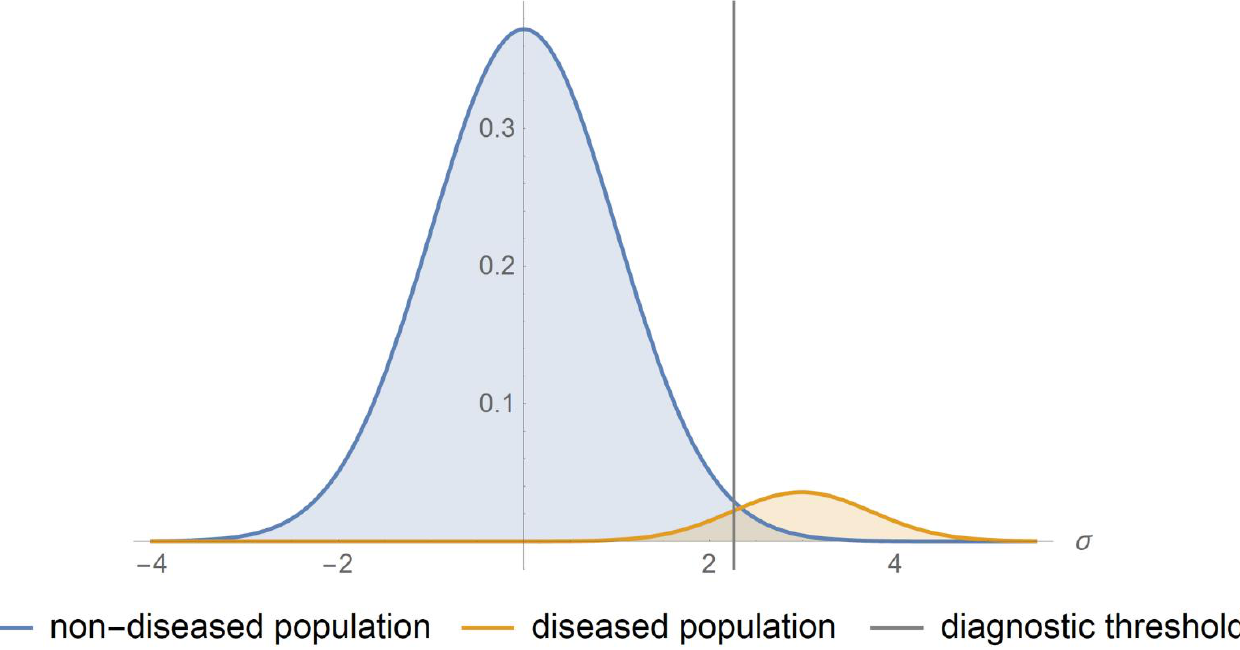
Table 1. A 2 × 2 contingency table.